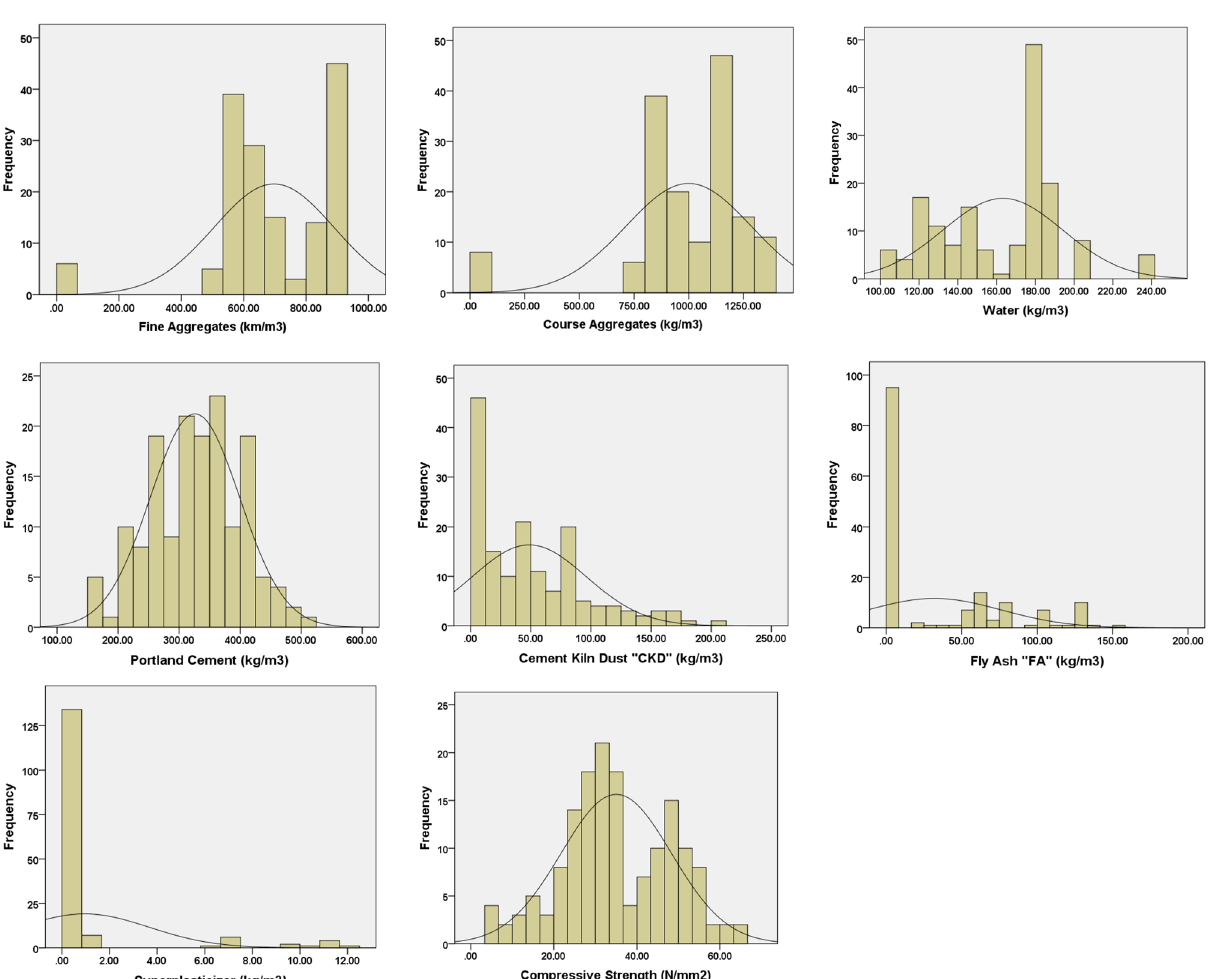
Figure 1. Frequency histogram of variable input parameters and